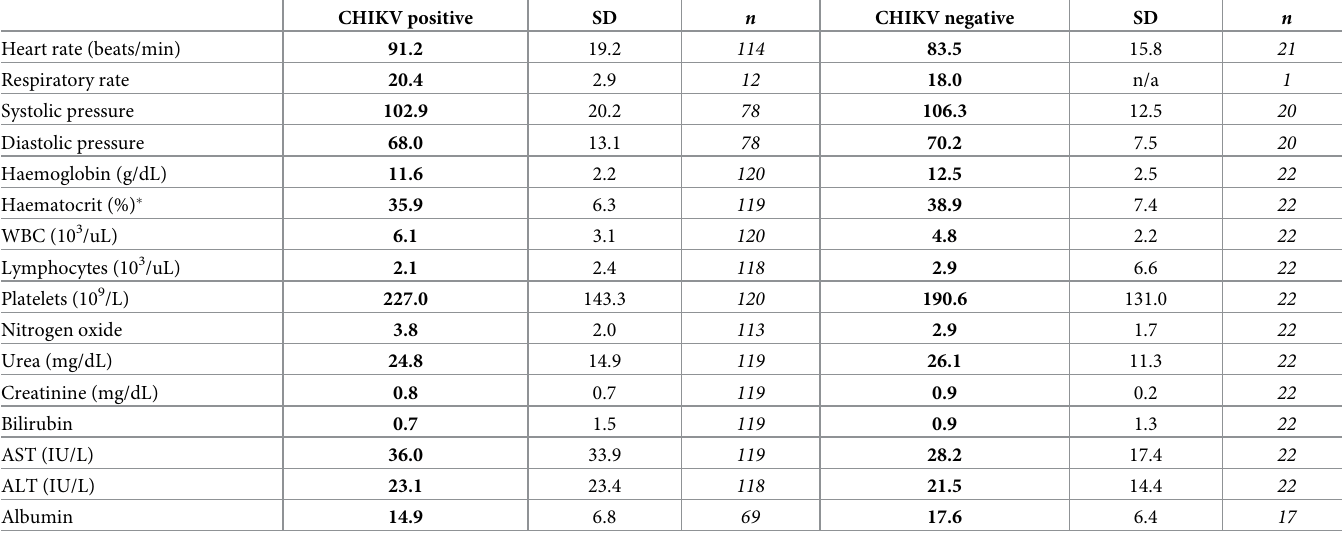
Table 3. Mean clinical parameters of participants at presentation by CHIKV RT-PCR